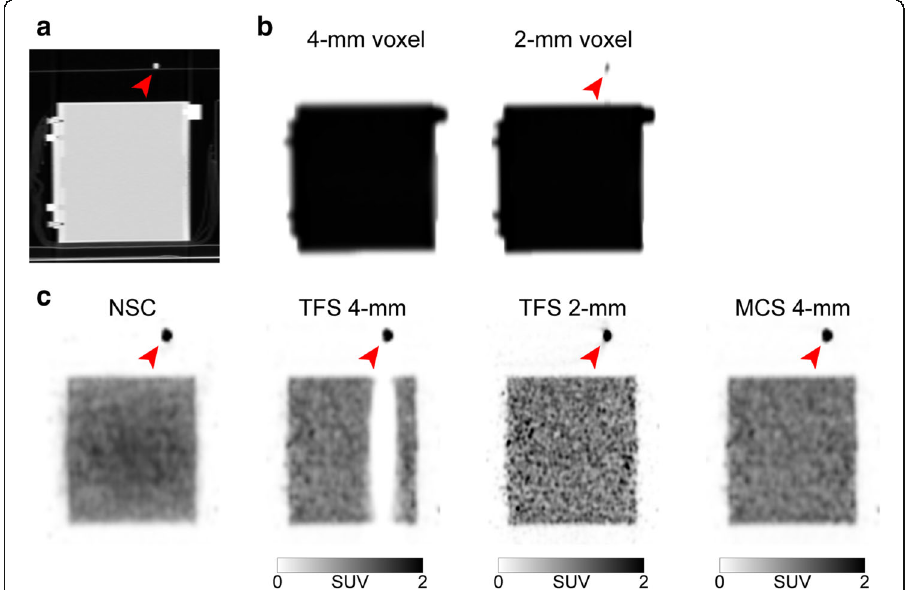
Fig. 9 Sagittal images of a phantom (tube curve pattern). CT image ( a ), 4-mm and 2-mm voxel μ -maps ( b ), FDG solution in the urinary catheter